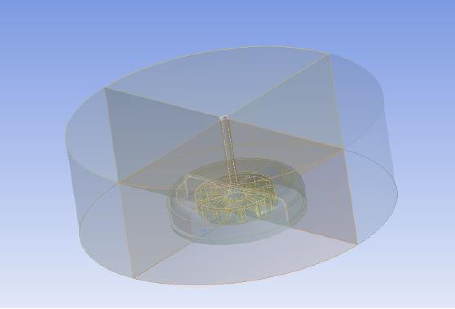
Figure 4. Simplified diagram of geometric model.